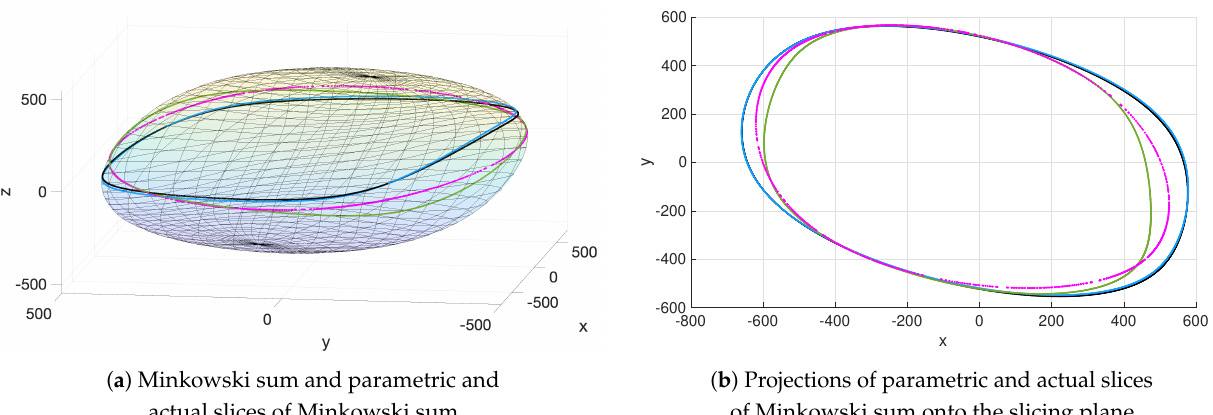
Figure 5. Parametric slices of Minkowski sum for similar Minkowski sum and height h of slicing plane to the sample in Figure 4a,b but for a different orientation of the plane. The parametric slices are computed by: MVOE from minimization of (7) (black), John’s inner bound (12) (blue) and the second eigenvalue λ 2 ( A T A i ) in (16) (green). The actual slice of Minkowski sum is pink. i In line with the current discussion of the destructive impact of curvature of the Minkowski surface on the accuracy of the suggested parametric model for the slice of Minkowski sum, Figure 6 represents another type of condition under which the Minkowski surface might likely have high curvature at particular zones. This is the case in which the constituting ellipsoids of the Minkowski sum have a “strong” high aspect ratio. For an ellipsoid with a “strong” high aspect ratio, not only the ratio of the lengths of major semi-axis (third semi-axis) to the minor semi-axis (first semi-axis) is high but also this ratio is high between the major semi-axis and the second semi-axis, so that the ellipsoid has a “cigar” shape. For the same reason as the high curvature of the Minkowski surface, the parametric approximation of the slice of Minkowski sum of two cigar ellipsoids shows weak modeling of the actual